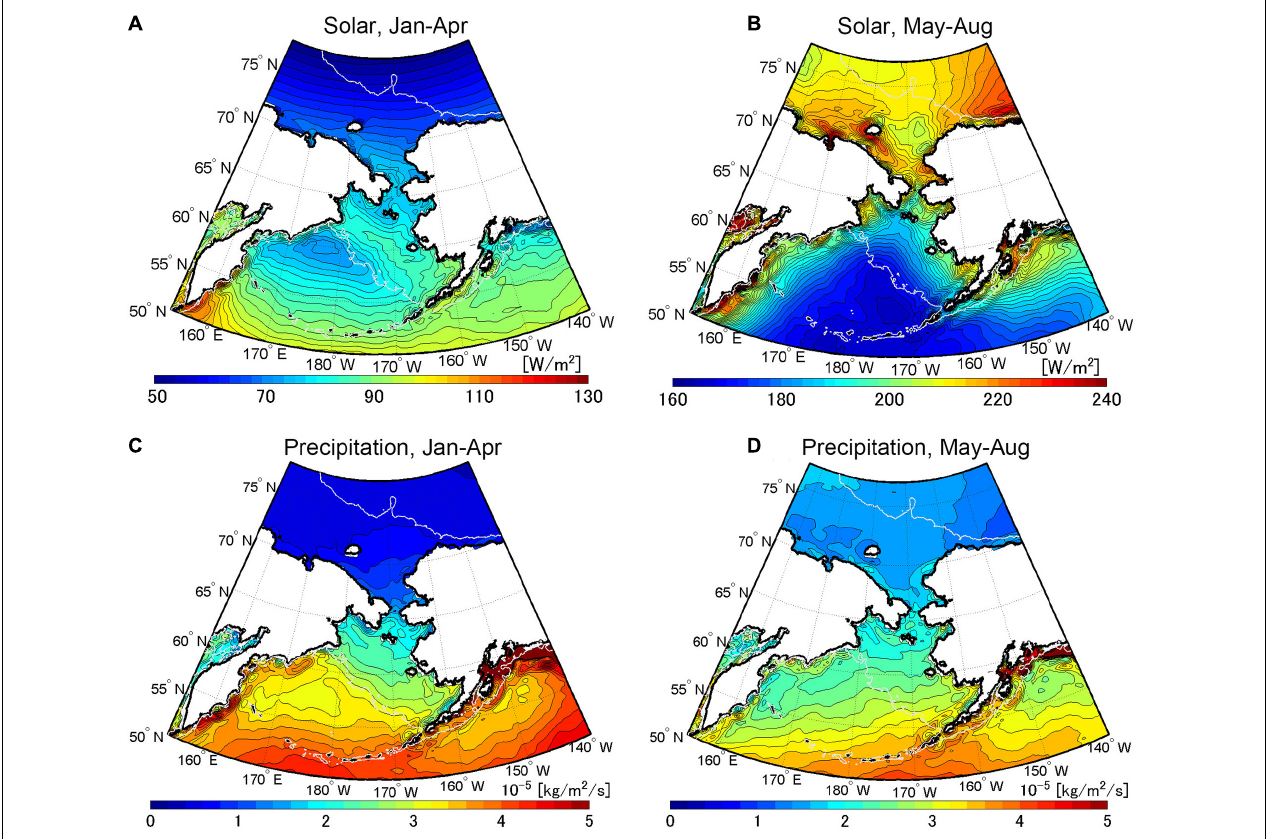
FIGURE 9 | Climatology of (A,B) solar radiation at the sea surface and (C,D) precipitation rate for (A,C) January to April and (B,D) May to August. White lines are depth contours of 200 m.